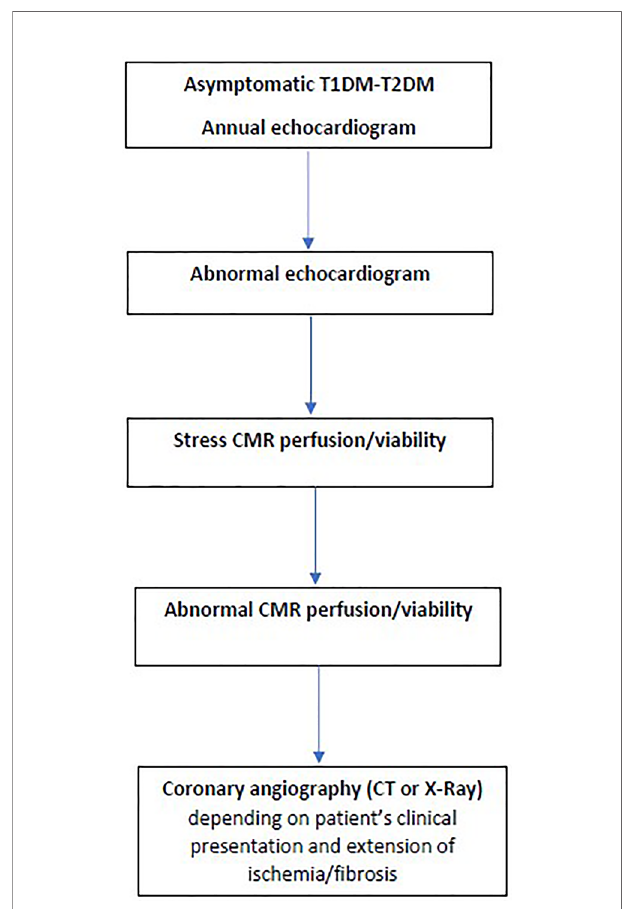
FIGURE 7 | Suggestive algorithm for the evaluation of CAD in